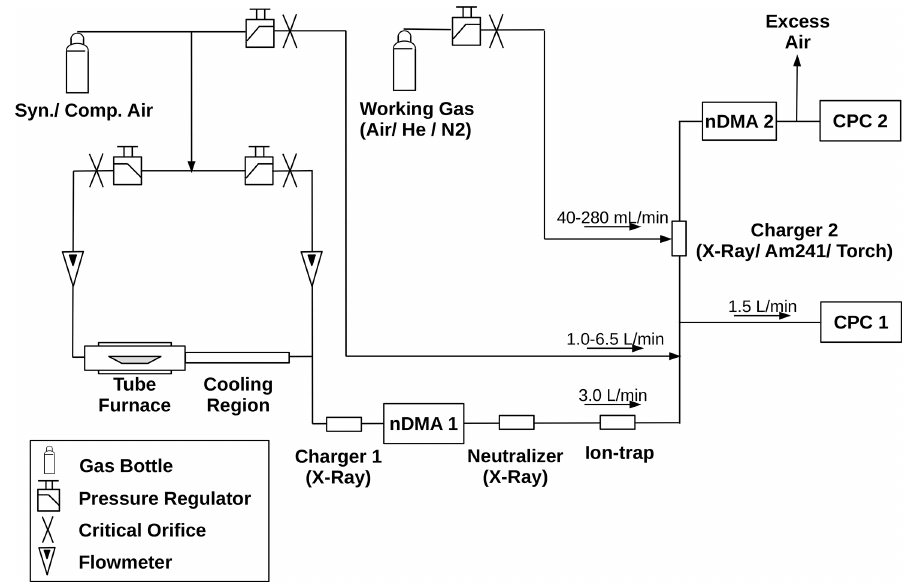
Figure 1. Schematic of the experimental setup for the charging probability and particle size conservation measurements. The additional working gas flow is only needed for the plasma charger. See text for explanation.